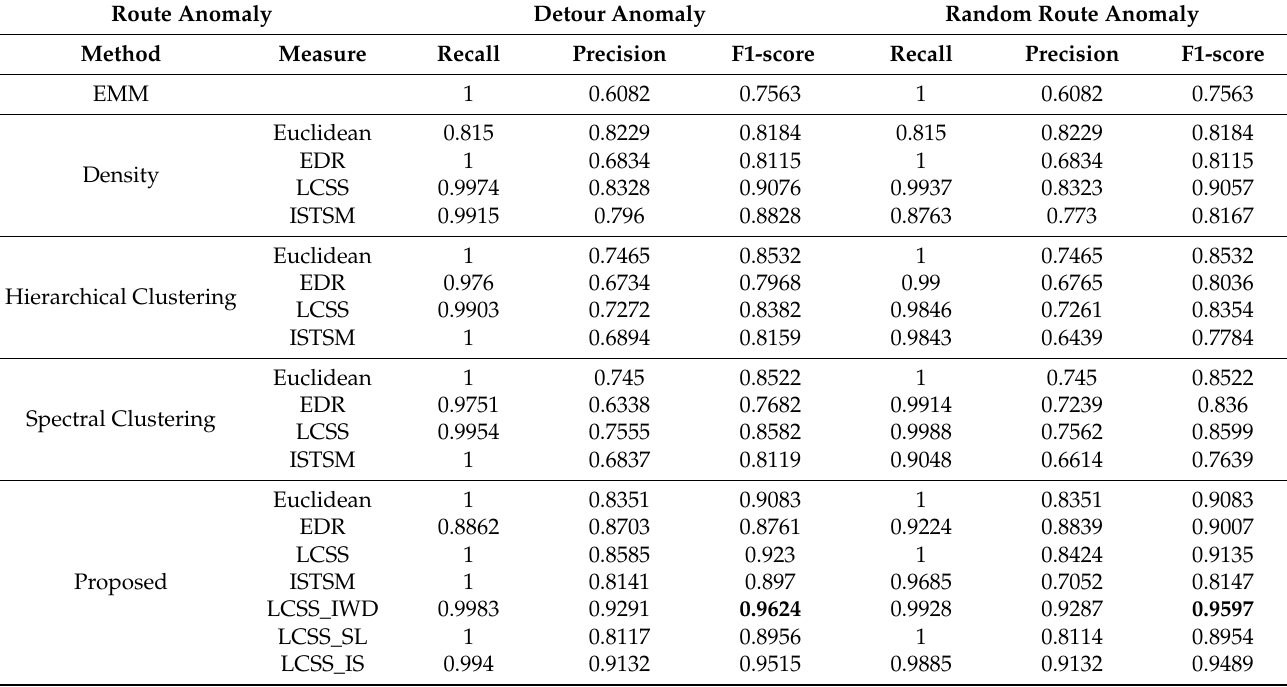
Table 5. Results with route anomalies on the MIT Badge dataset.